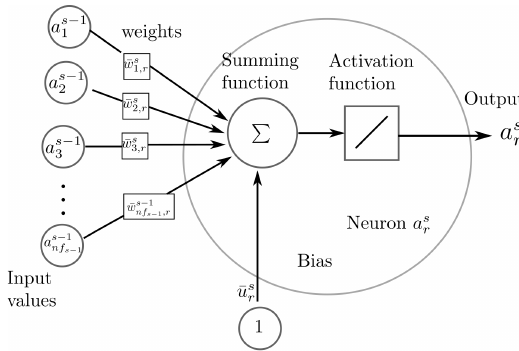
Figure 2. Artificial neuron or node in the NCH